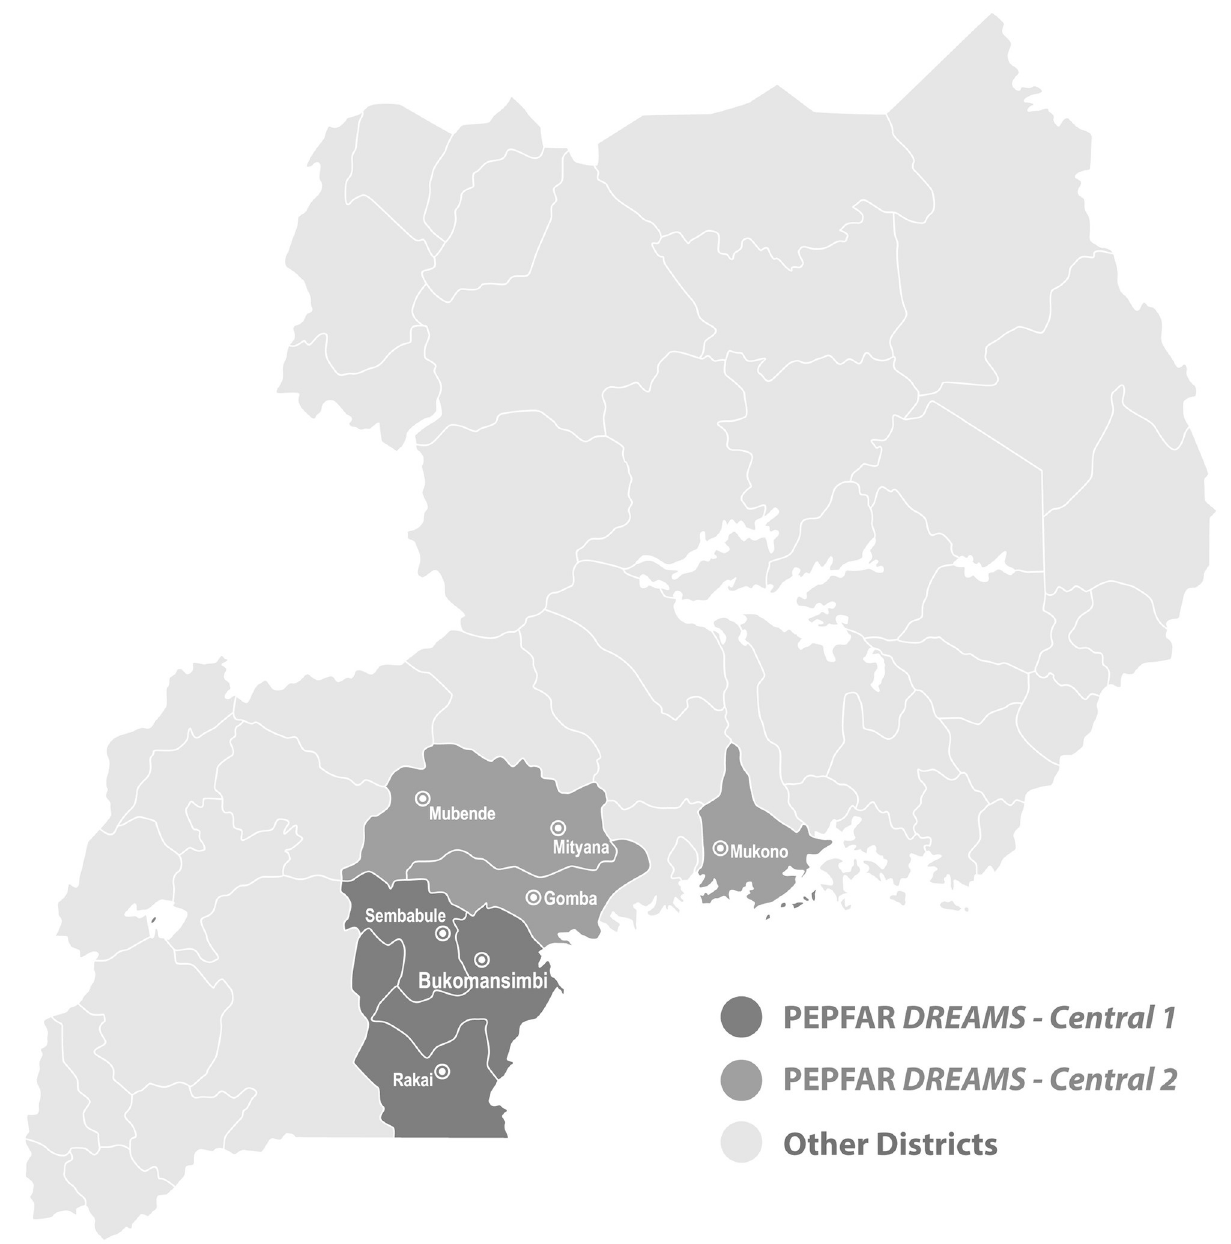
Fig 1. Uganda PEPFAR DREAMS